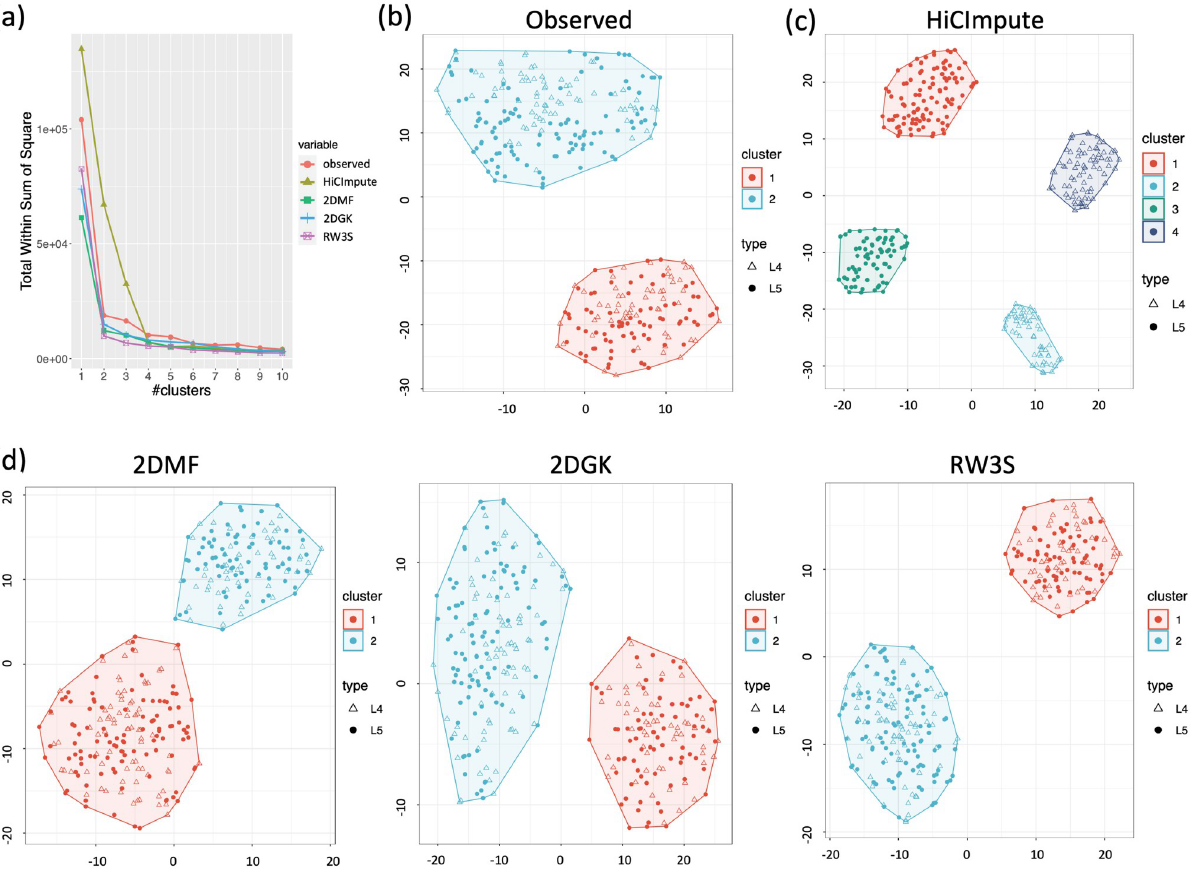
Fig 3. Comparison of results from HiCImpute, 2DMF, 2DGK, and RW3S via t-SNE visualization and clustering with K-means. (a) Plots of total within-cluster sum of squares versus number of clusters for K-means analysis; (b) t-SNE visualiation and K-means clustering boundaries based on observed data; (c) Same as (b) but based on HiCImpute-improved data; (d) Same as (b) but based on 2DMF, 2DGK, or RW3S-improved data.